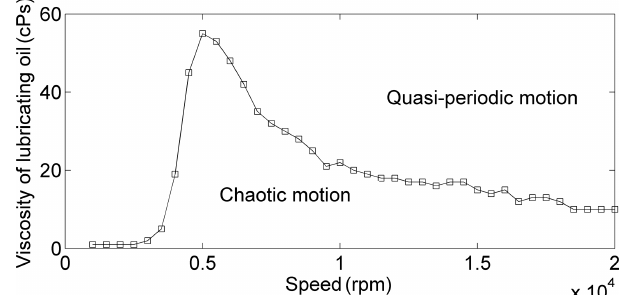
Figure 10. Critical viscosity of lubricating oil. Figure 11. Bifurcation at the torque load of 2500Nm and the lubri- cating oil viscosity of